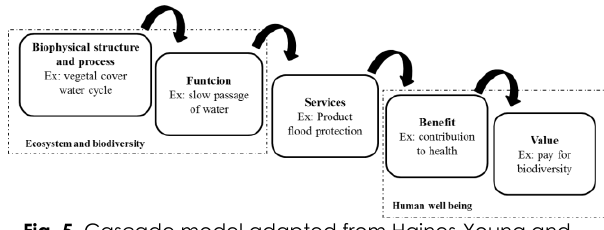
Fig. 5. Cascade model adapted from Haines-Young and Potschin (2010) (Source: Pesche and Méral,